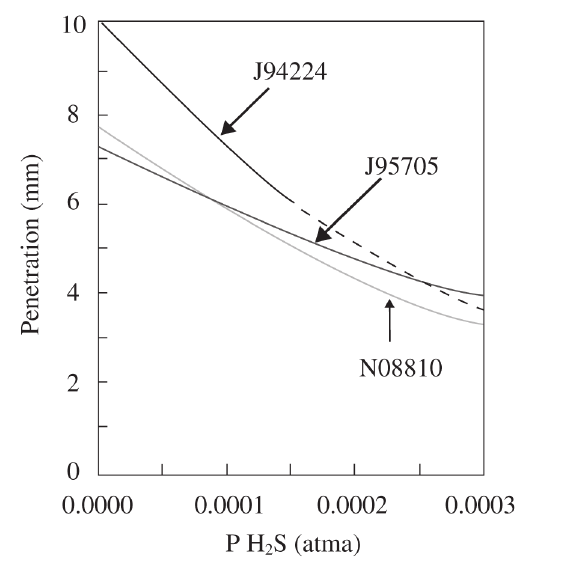
Figure 9. Effect of PH Exposed to Carbon Activity of 1.0 in H 1000 °C, after one year.